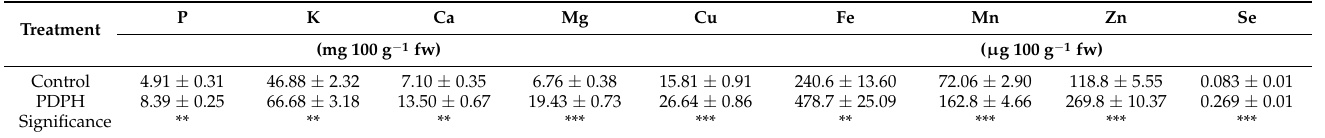
Table 5. Macro- and micronutrients content of spinach plants under control or vegetal-derived protein hydrolysate (VPDH)